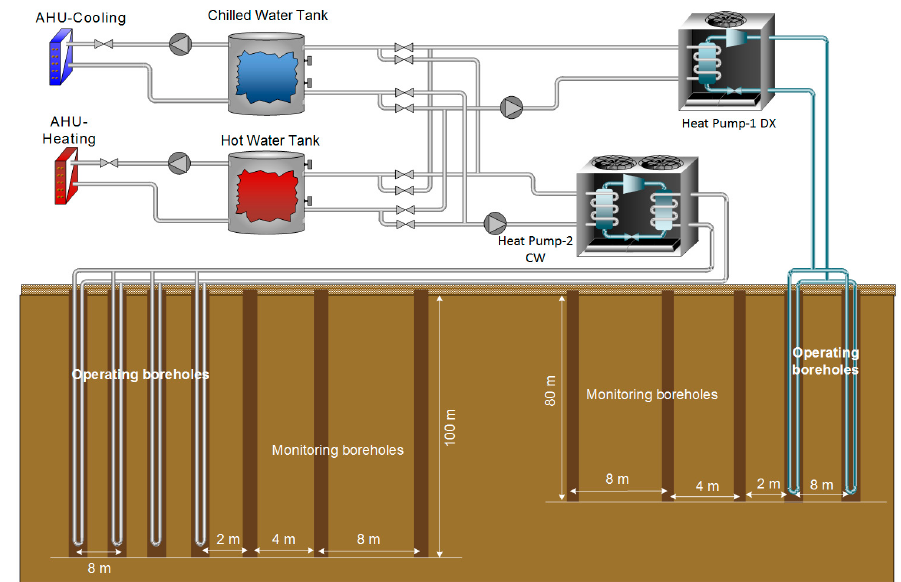
Figure 2. Gatton GSHP Facility schematic, showing air handling units (AHUs), water tanks, the two separate refrigerant direct expansion (DX) and condenser water (CW) heat pumps and their respective ground heat exchangers and monitoring wells. Table 2. Specifications of the two Gatton ground source heat pump systems.